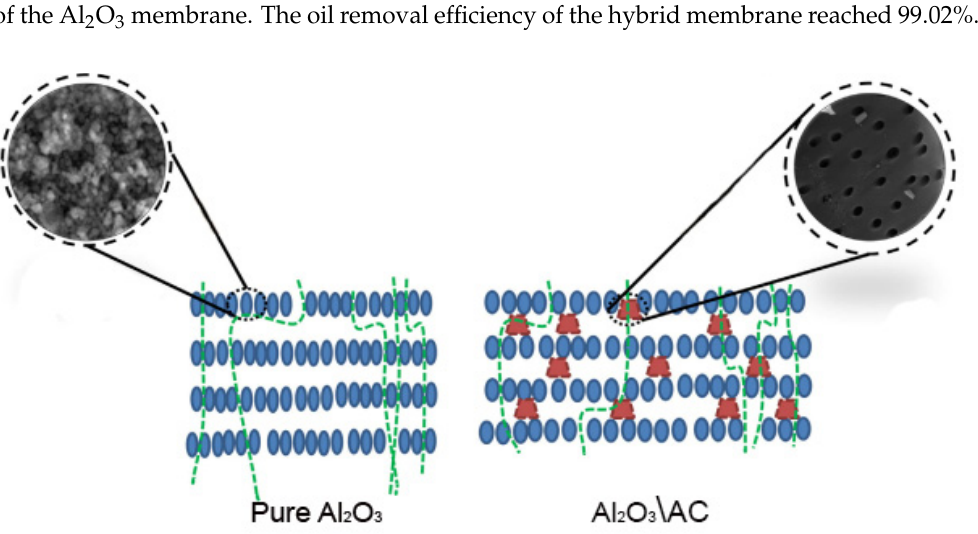
Figure 6. Comparison of Al 2 O 3 and Al 2 O 3 /activated carbon hybrid membrane. The inclusion of carbon in the aluminum oxide matrix can increase the porosity of the structure, thereby causing additional microchannels for water to pass through the membrane. This leads to an increase filtration and adsorption efficiency. Diagram taken from [88].